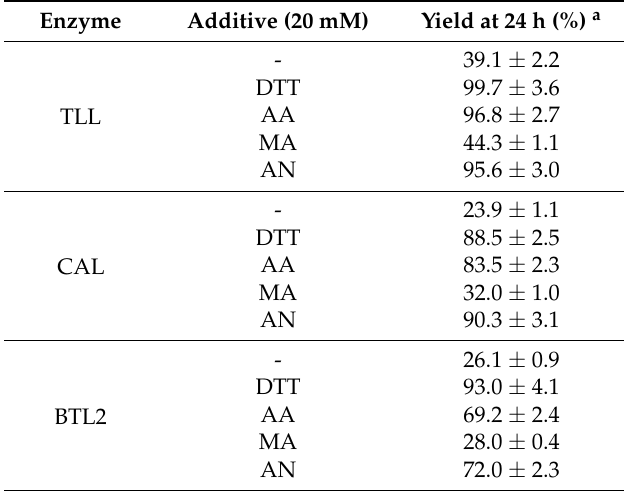
Table 1. Immobilization yield of aminated lipases in presence of different additives at neutral pH and 25 ◦ C.